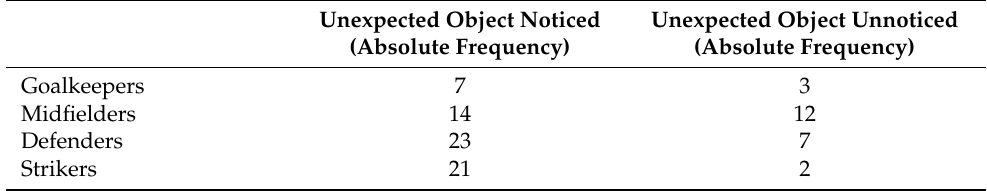
Table 2. Rates of noticing the unexpected object (absolute frequency) per group. Unexpected Object Noticed Unexpected Object Unnoticed (Absolute Frequency) (Absolute Frequency) Goalkeepers